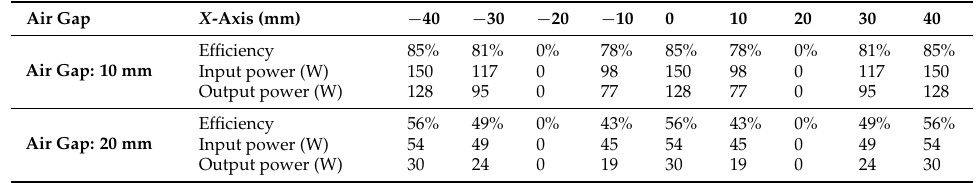
Figure 8. Efficiency, input power, and output power of the IPT system in motion. ( a ) Air gap: 10 mm ( b ) Air gap: 20 mm. Table 6. Motion effect of the IPT system as moving along X -axis; mode 1H (fsw: 20